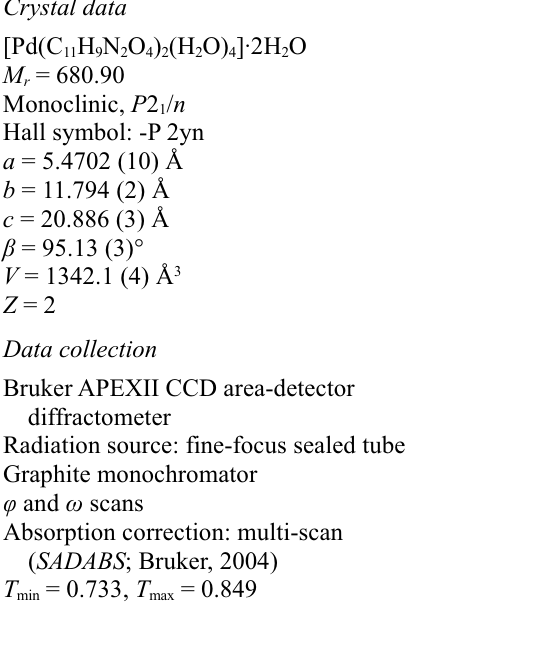
Figure 2 The packing of (I) with hydrogen bonds shown as dashed lines. Tetraaquabis[(1-carboxylatomethyl-1,3-benzimidazol-3-ium-3-yl)acetato- κ O]palladium(II) dihydrate Crystal